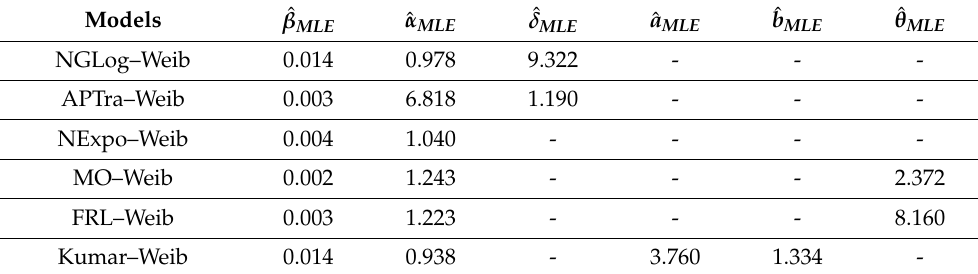
Figure 4. For dataset 1, the ( a ) histogram, ( b ) kernel density plot, ( c ) TTT plot, ( d ) violin plot, and ( e ) box plot. Table 6. The ˆ β MLE , ˆ α MLE , ˆ δ MLE , ˆ a MLE , and ˆ b MLE values for infected guinea pigs data (dataset 1).